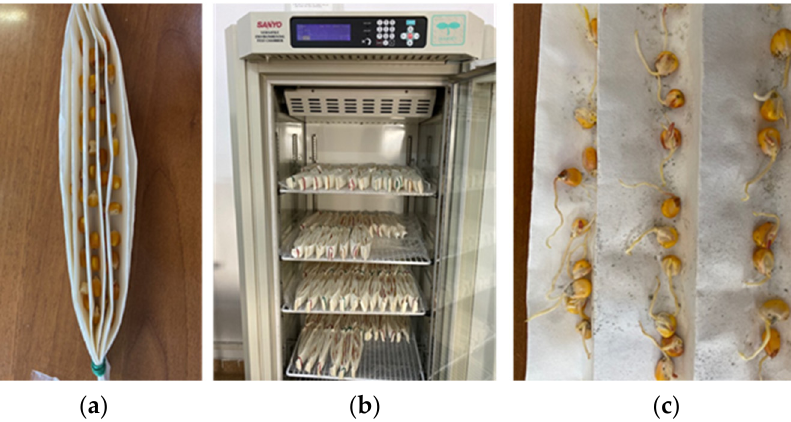
Figure 13. Seeds in paper towel for germination test ( a ), seeds placed in the germination chamber ( b ) and germinated seeds on 7th day ( c ) .